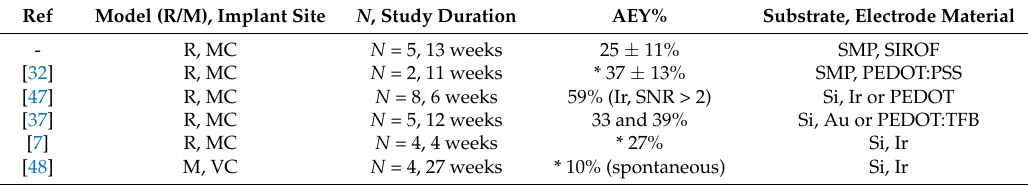
Table 2. Planar single-shank electrode array comparison. Active electrode yield (AEY) percentage represents spontaneous single-unit activity unless otherwise indicated.